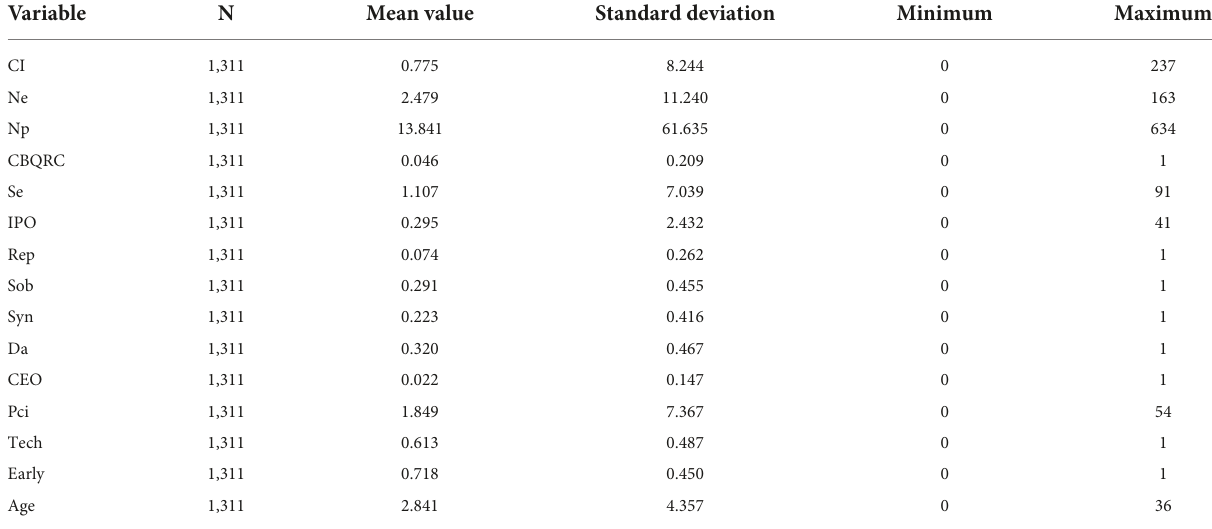
TABLE 2 Summary